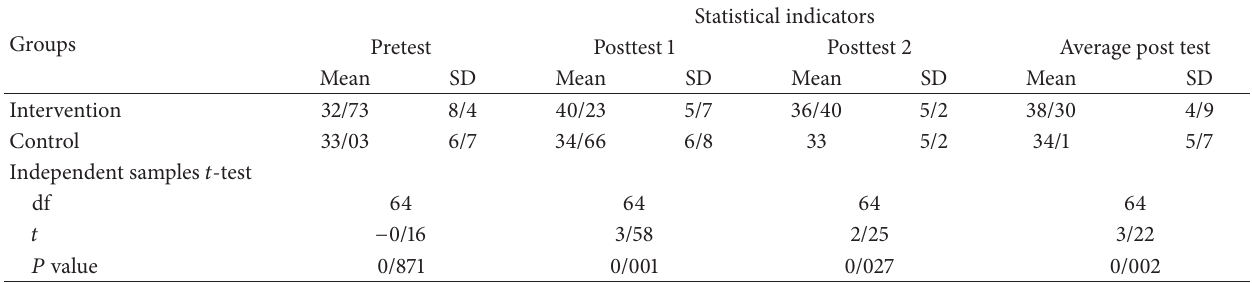
Table 1: Comparison of self-esteem in adolescents between exercise groups (intervention) and control before, immediately after, and one month after intervention.